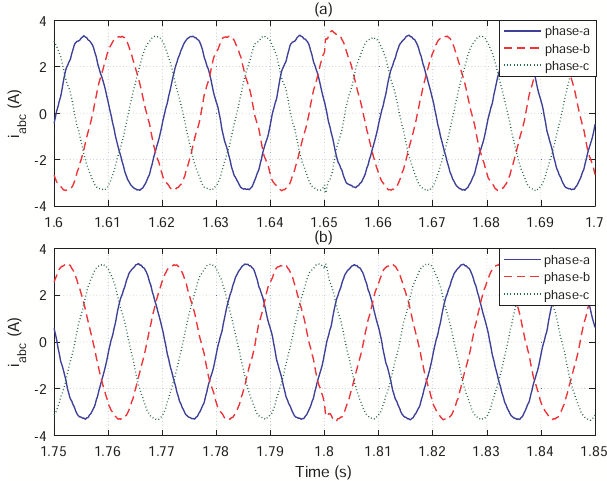
Figure 12. Current waveform of PV system during load conversion under DFA-SMB